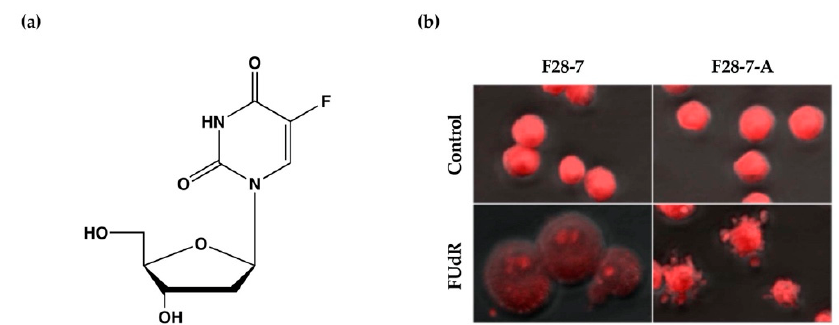
Figure 1. ( a ) Chemical structure of anticancer drug floxuridine (5-Fluoro-2 ′ -deoxyuridine, FUdR). ( b ) Cell death morphological changes induced by FUdR in F28-7 and F28-7-A cell lines. FUdR induces necrosis in F28-7 and apoptosis in F28-7-A. Control, no treatment; FUdR, cells were treated with 1 μ M FUdR for 21 h. Figure 1( b ) modified from Ref. [9] . Table 1. The biological and morphological features of FUdR-induced cell death.